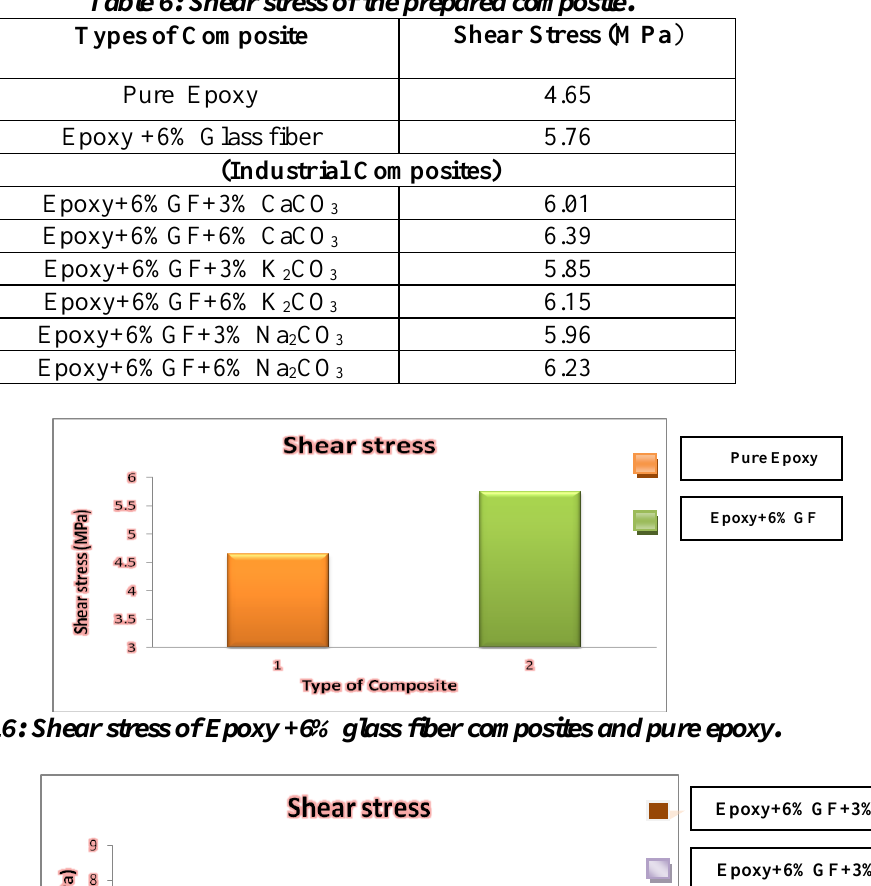
Table 6: Shear stress of the prepared composite.